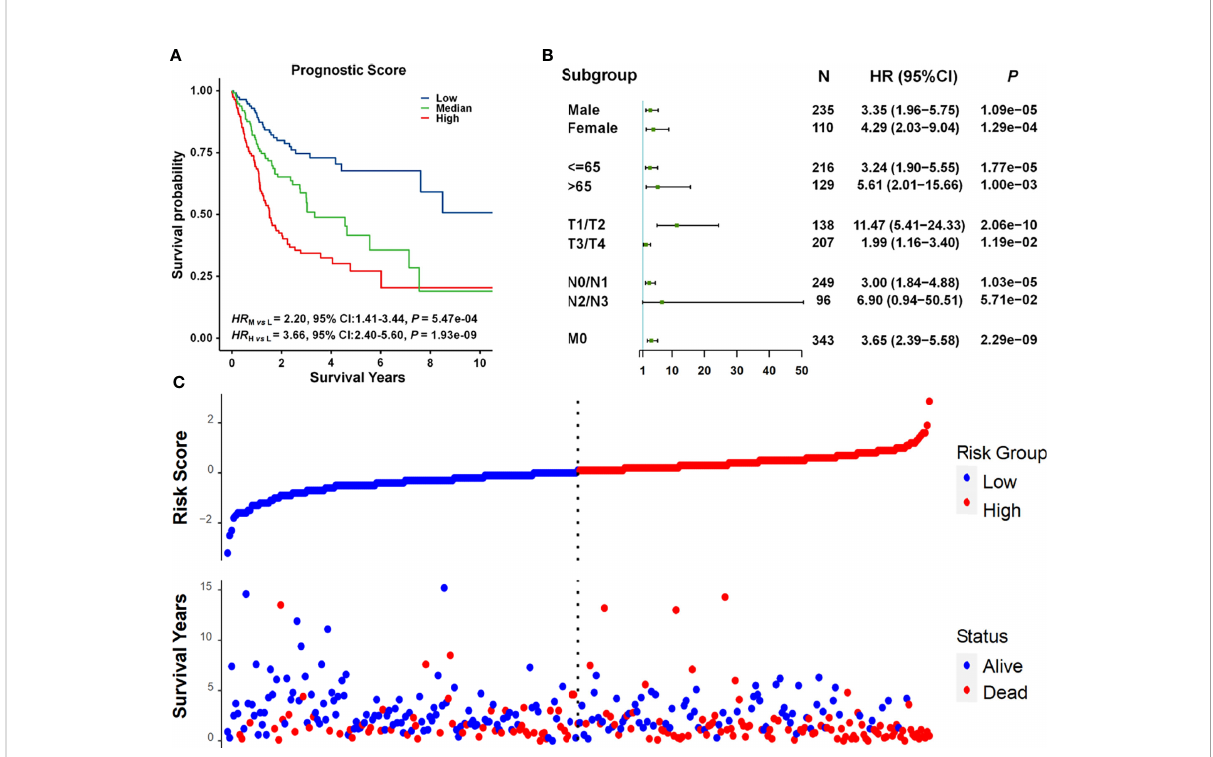
FIGURE 4 Survival analysis of prognostic scores. (A) Kaplan – Meier survival curves for patients grouped by prognostic scores. Patients were categorized into three subgroups by using the tertiles of prognostic scores. The number of patients in each group was 115. (B) Forest plots of results from association analysis of the relationship between prognostic scores and overall survival. HR , 95% CI, and p- values were derived from the Cox proportional hazards regression model. (C) The relationship between prognostic scores and survival